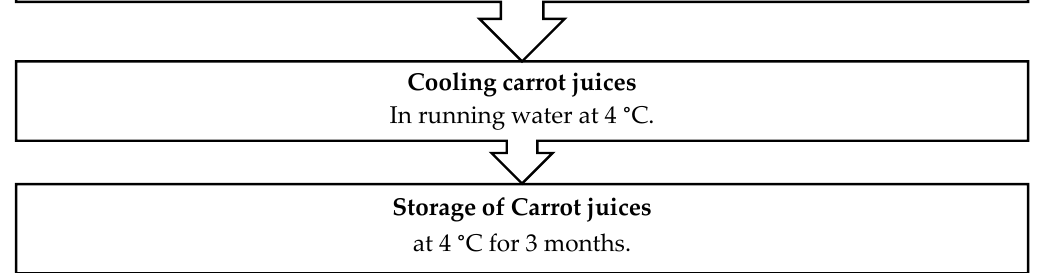
Figure 1. Scheme of production of carrot juice.